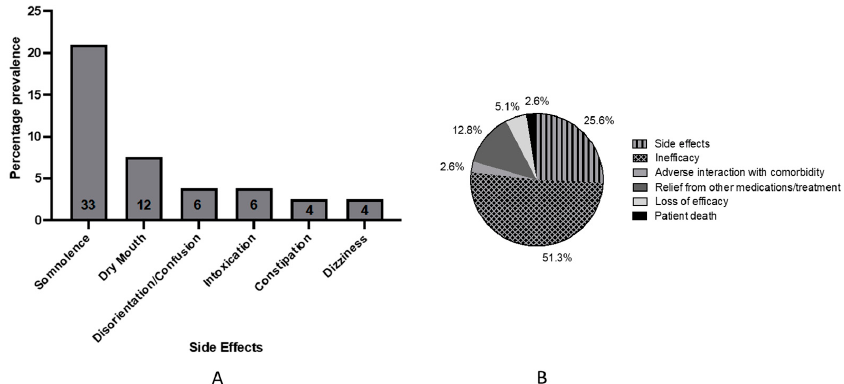
Figure 5. Safety and treatment status: ( A ) Prevalence of the six most common side effects ( n = 65). The number of patients who reported each side effect is displayed within each column and percentages calculated from total population ( n = 157); ( B ) Reasons for treatment cessation ( n = 39). Inefficacy = no effect on condition/indication, Loss of efficacy = initial effect wore off over time.